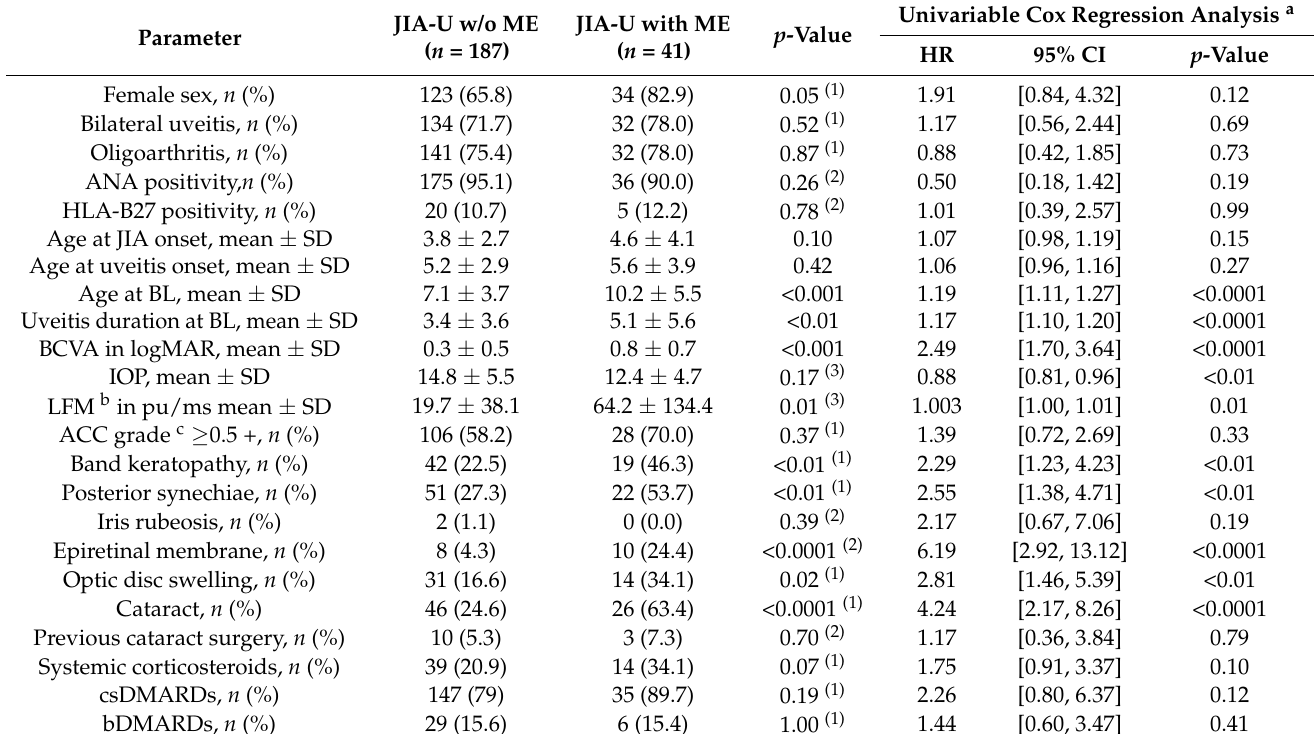
Table 2. Patients with juvenile idiopathic arthritis-associated uveitis (JIA-U): occurrence of macular edema (ME). Character- istics at